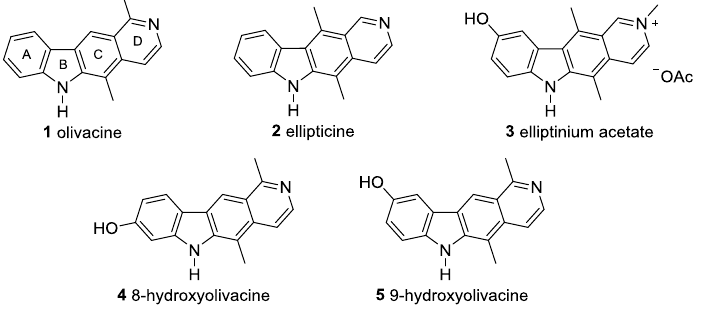
Figure 1. Pyrido[4,3- b ]carbazole alkaloids and oxygenated derivatives.